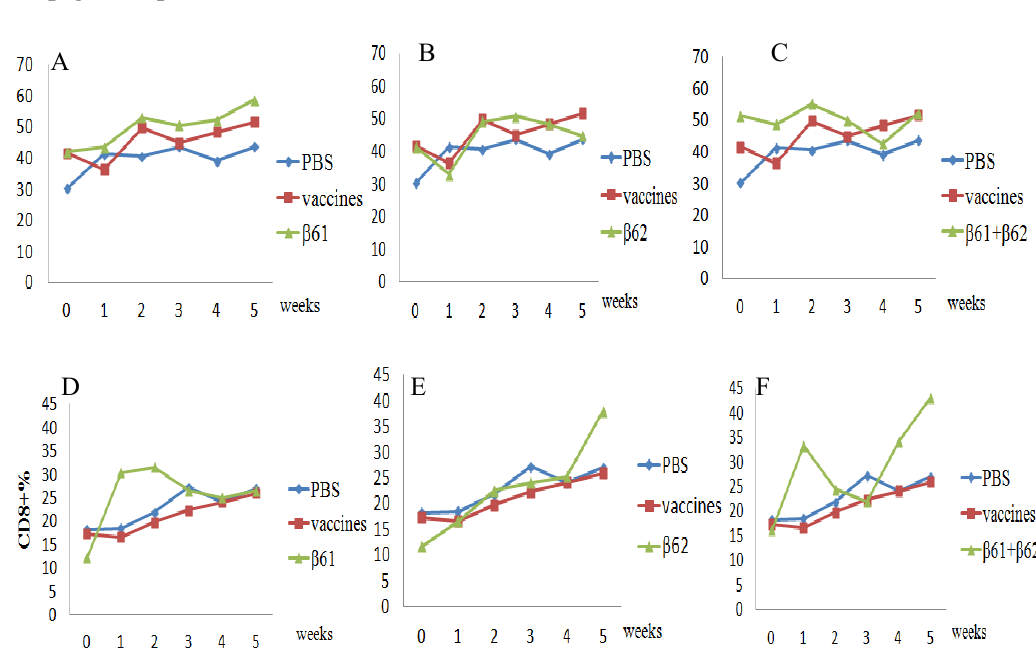
Figure 6. Cell-mediated immune response in guinea pigs vaccinated with PBS, conventional O-type foot-and-mouth disease (FMD) vaccine, β 6-1, and β 6-2. The upper panels show CD4 + lymphocyte proliferation in β 6-1-inoculated guinea pigs (A), β 6-2-inoculated guinea pigs (B), and β 6-1+ β 6-2-inoculated guinea pigs (C) compared to the PBS- and vaccine-inoculated animals. The lower panels show CD8 + lymphocyte proliferation in β 6-1-inoculated (D), β 6-2-inoculated (E), and β 6-1+ β 6-2-inoculated (F) guinea pigs compared to the PBS- and vaccine-inoculated animals.